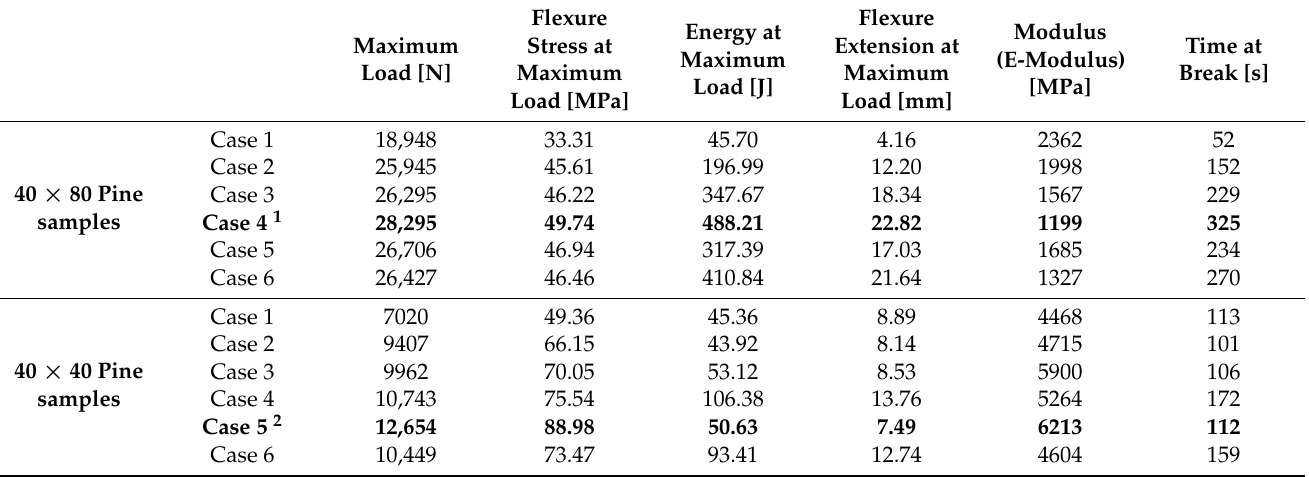
Table 2. Summary of results from the experiments.